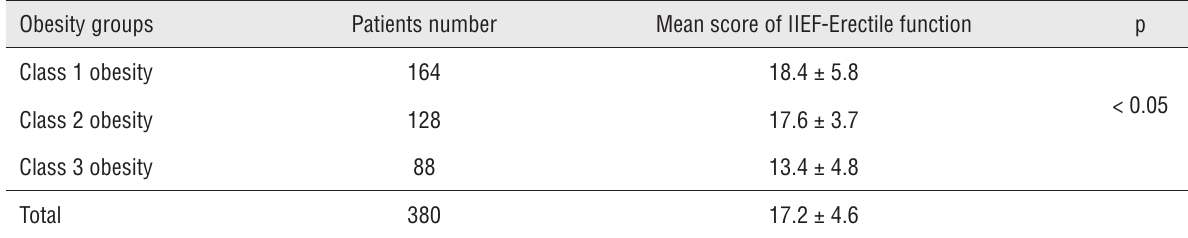
Table 3 - Relationship between the erectile function and obesity groups. Obesity groups Patients